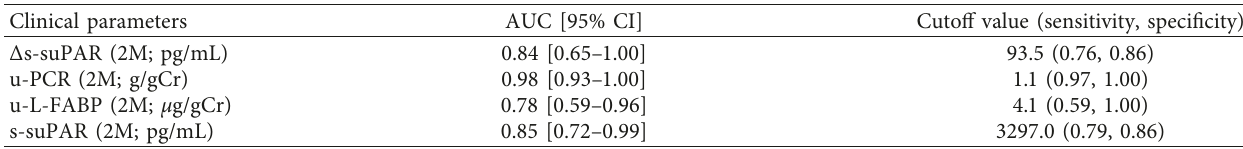
Table 5: Cutoff values of predictive factors for intractable